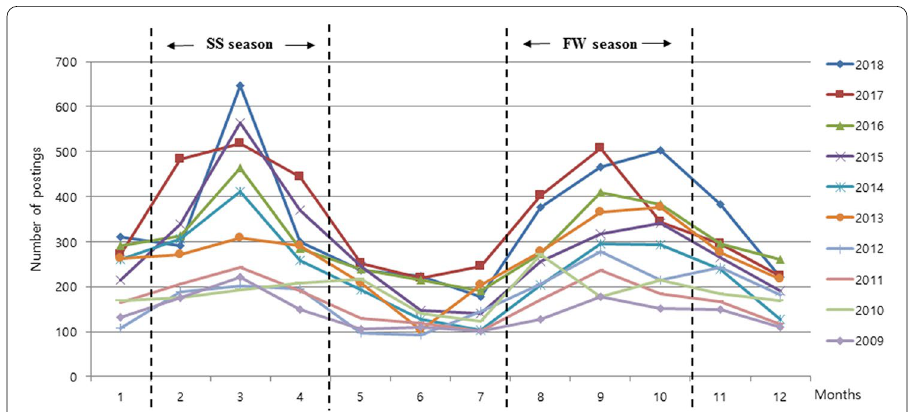
Fig. 1 Number of posts collected between 2009 and 2018. The number of posts is high in the period from February to April (spring/summer season) and from August to October (fall/winter season) in the last 10